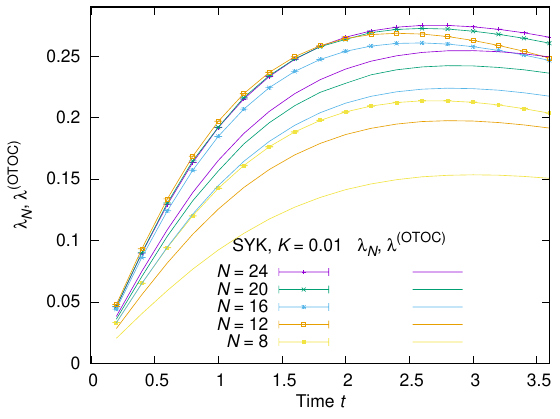
Figure 9 . (cid:21) N (with data points and error bars) and (cid:21) (OTOC) (with the same color as (cid:21) N but data points omitted) plotted against time t for the generalized Majorana SYK model with K = 0 : 01.